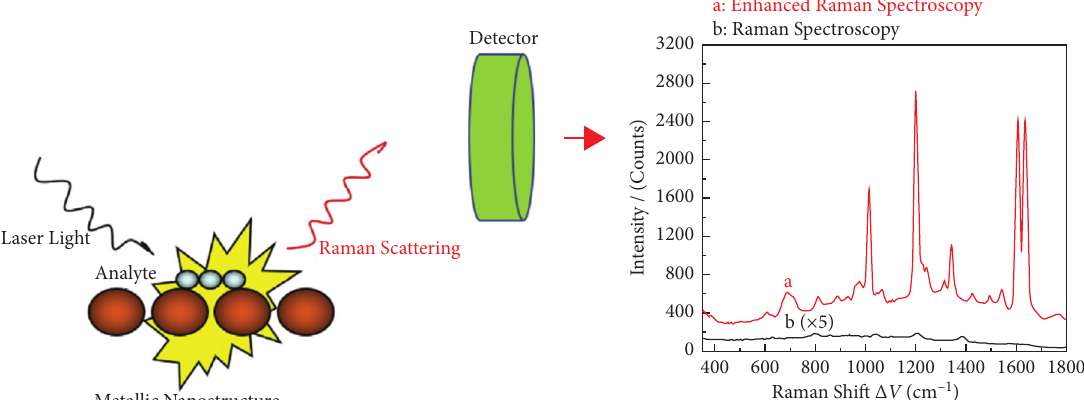
Figure 2: Illustration of SERS mechanism Table 2: A summary of various antibiotic drugs that have been analyzed in foods by using SERS with various active substrates. Antibiotics